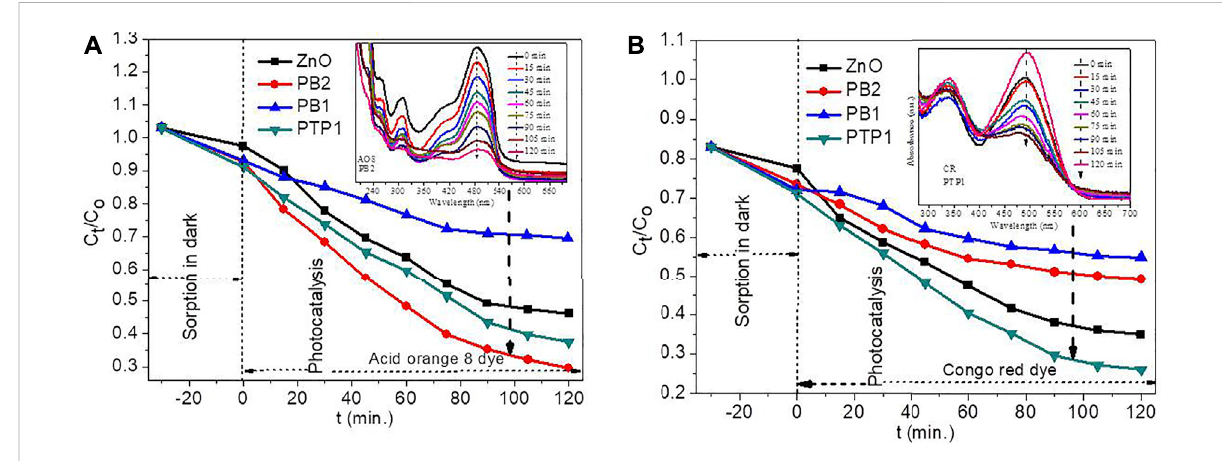
FIGURE 8 Photocatalytic activities of ZnO, PB1, PB2, and PTP1 on the (A) acid orange 8 and (B) congo red